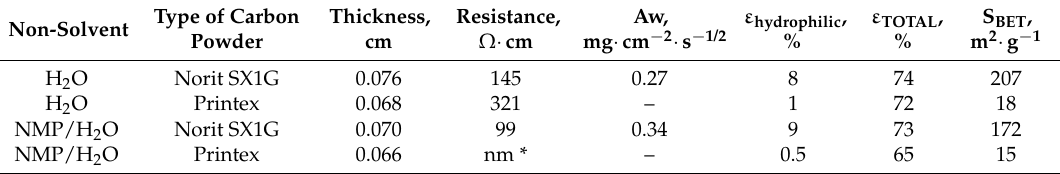
Table 2. Influence of the composition of the coagulation bath and of the type of active carbon used on the properties of the cast active layer (composition 70 wt % C:30 wt %